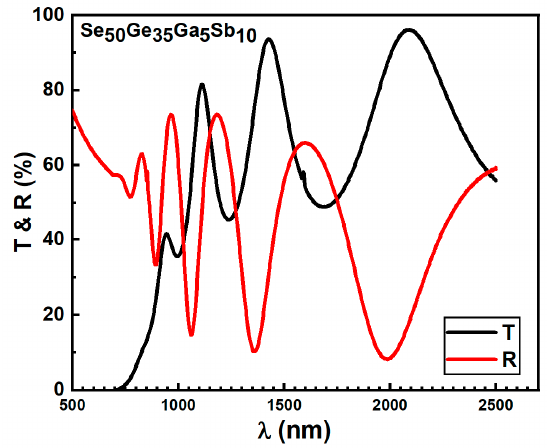
Figure 4. Transmittance and reflectance spectra of Se 50 Ge 35 Ga 5 Sb 10 film.